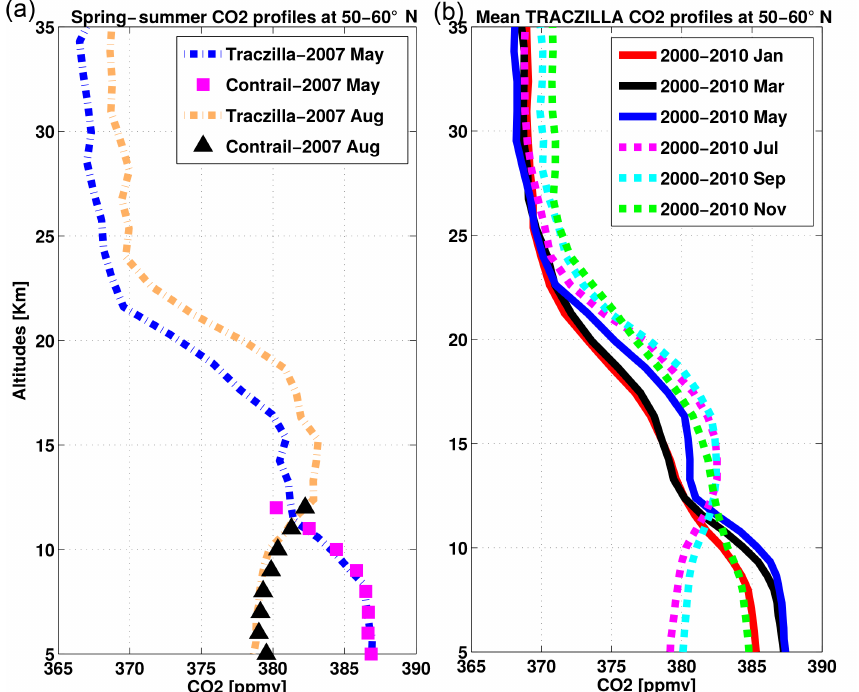
Figure 7. (a) Reconstructed vertical profiles of the mean CO 2 compared with CONTRAIL measurements for 2007 at 50–60 ◦ N. Dotted and dashed lines show vertical profiles of CO 2 from TRACZILLA (blue: May, orange: August). Symbols show in situ aircraft measurements from the CONTRAIL campaign (magenta square: May, black triangle: August). (b) Averaged monthly profiles of the reconstructed CO 2 over the period 2000–2010 after removal of the mean CO 2 trend at each level and centred on 2007. Red is January, black is March, blue is May, magenta is July, cyan is September, and green is